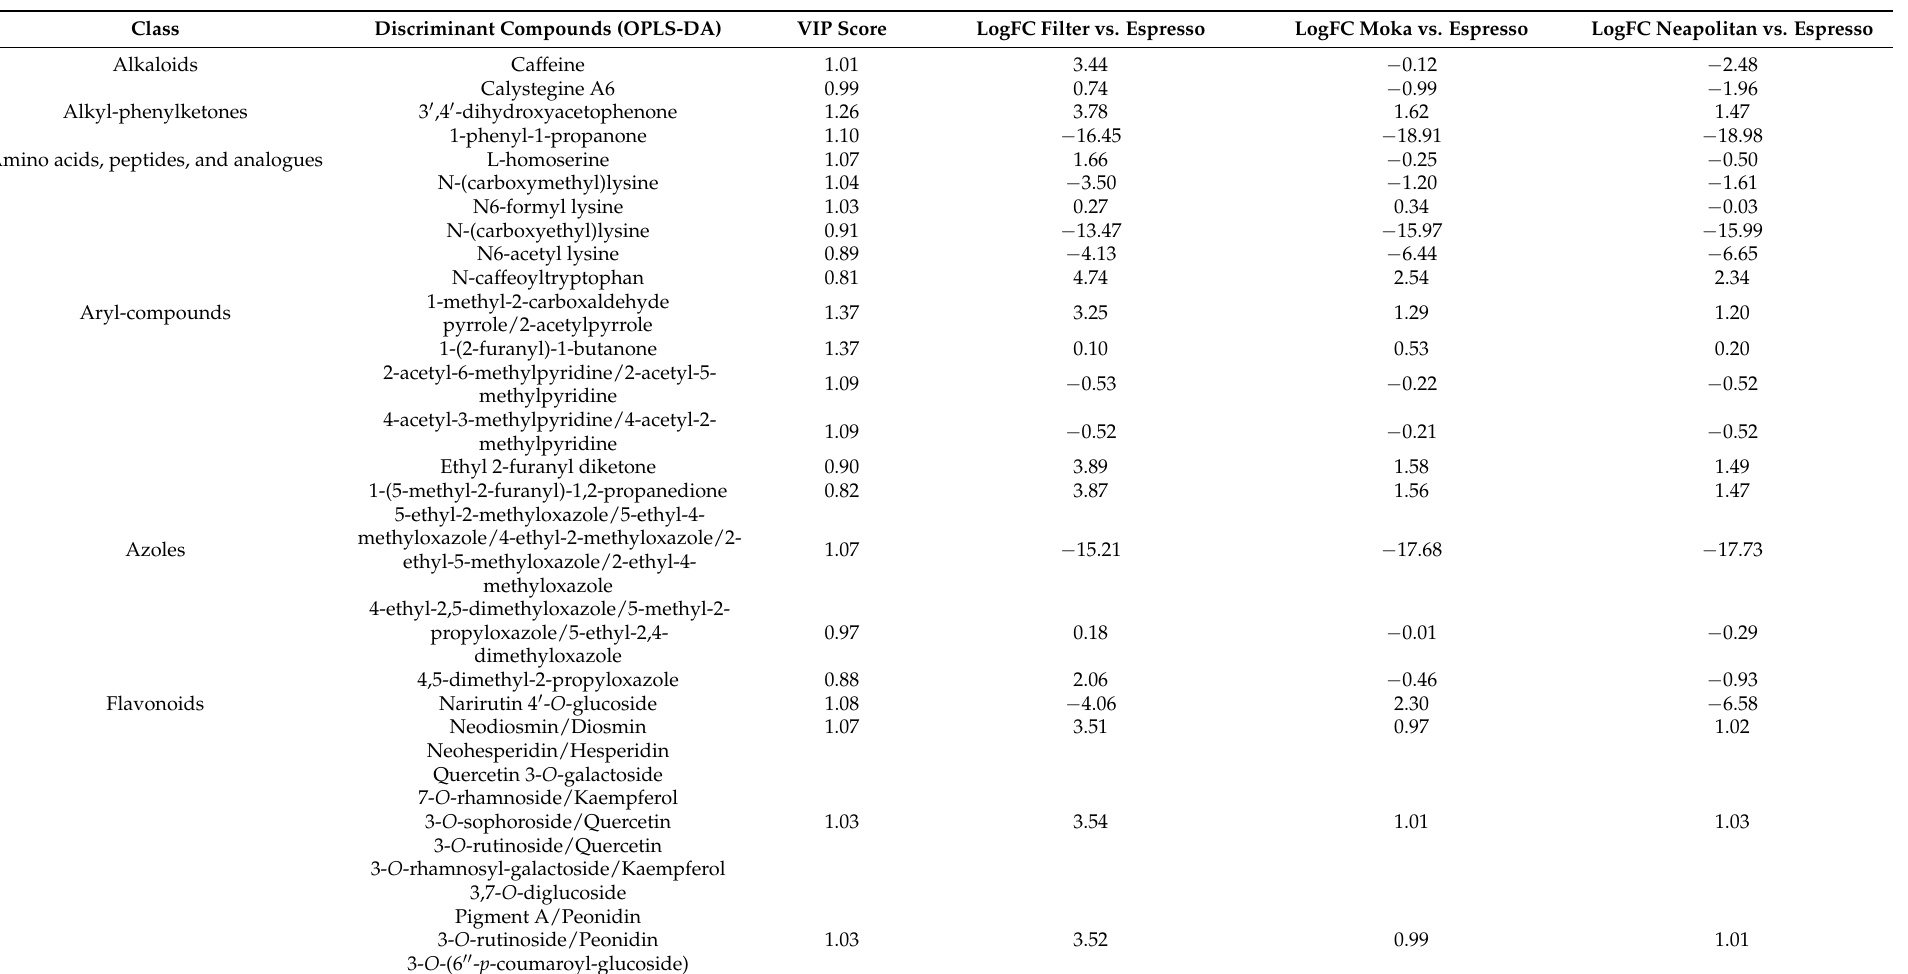
Table 1. Classified VIP discriminant compounds (VIP score > 0.8) following the OPLS-DA supervised statistics and considering the comparisons of Filter, Moka, and Neapolitan vs the Espresso extraction system, according to the Log2 Fold-Change (FC)